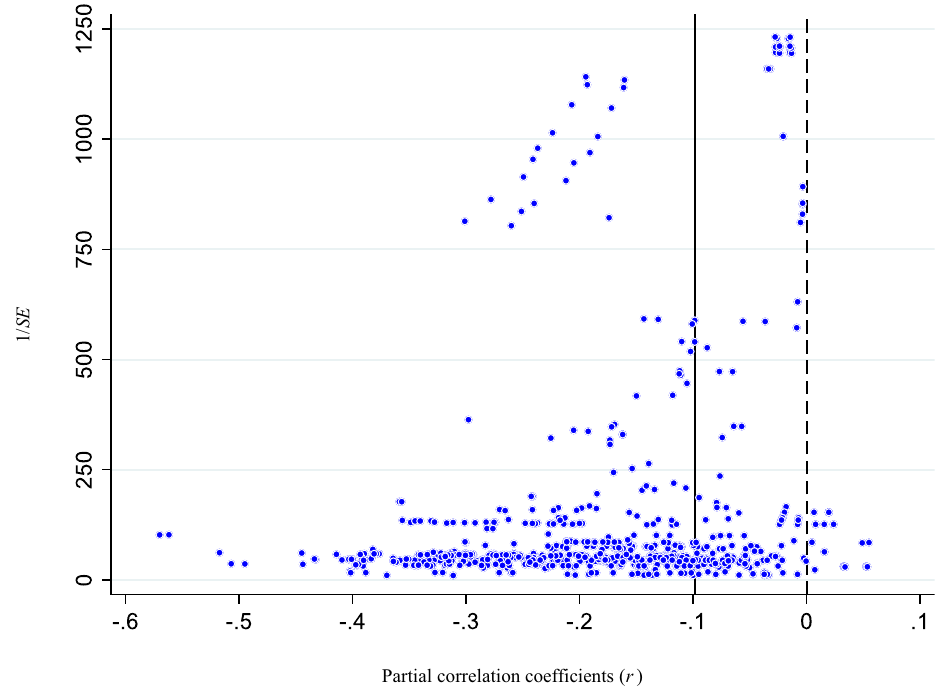
Fig. 4 Funnel plot of partial correlation coefficients. This figure displays a funnel plot of partial correlation coefficients of estimates of the gender dummy variable reported in 53 research works listed in Additional file 1: Table S1 and Additional file 2: Bibliography of studies subject to meta-analysis as the dependent variable. See Table 1 for the descriptive statistics of the estimates. The solid line indicates the synthesized effect size by WAAP estimation as reported in Table